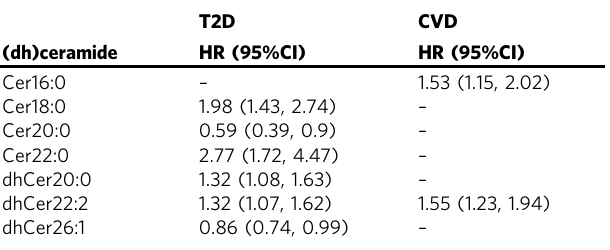
Hazard ratio (HR) per one standard deviation higher plasma concentration in the EPIC-Potsdam cohort. Riskestimatesarefromamodelthatmutuallyincludedallceramidesselectedasdirecteffectors by the NetCoupler-algorithm ( see methods section), further adjusting for total ceramide and total dihydroceramide concentrations, age (strata variable), sex, height, waist circumference, leisure- time physical activity, fasting status, antihypertensive medication, lipid-lowering medication, aspirin, total energy intake, smoking, alcohol consumption, educational attainment, plasma concentrations of triglycerides, total cholesterol, and systolic and diastolic blood pressure; baseline-prevalent T2D cases were excluded from the diabetes risk model, and adjusted for in the CVD risk model.